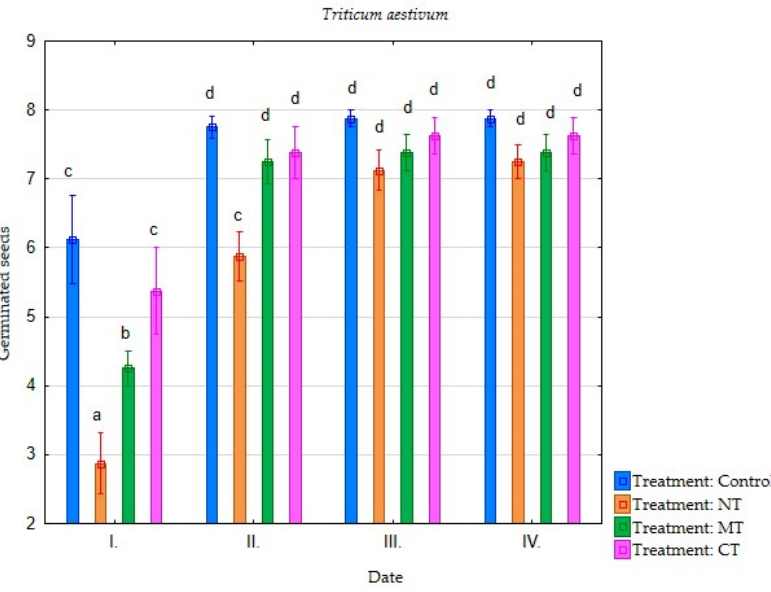
Figure 1. Development of the germination of Triticum aestivum caryopses watered with soil leachates from different soil tillage. The results represent the mean of 8 biological replicates ± SE. Identical letters express statistical non-significance between the variants, different letters express statistical significance at a significance level p = 0.05 (Fisher LSD test). The plot shows the mean, the whiskers representing the standard error, values with different letter (a, b, c, d) differ significantly. Variants of tillage technologies: CT—Conventional tillage with ploughing; MT—Minimum tillagethe; NT— Direct sowing.